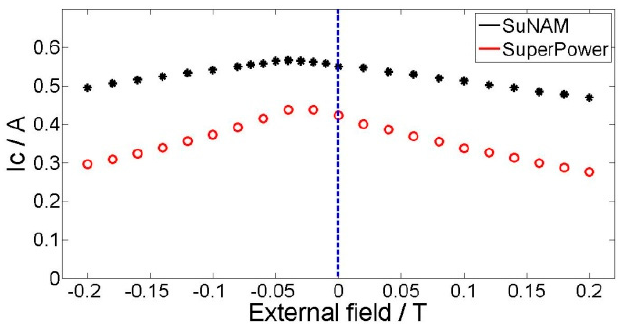
Figure 12. Simulated critical currents of coils after normalization with self-field tape I c .